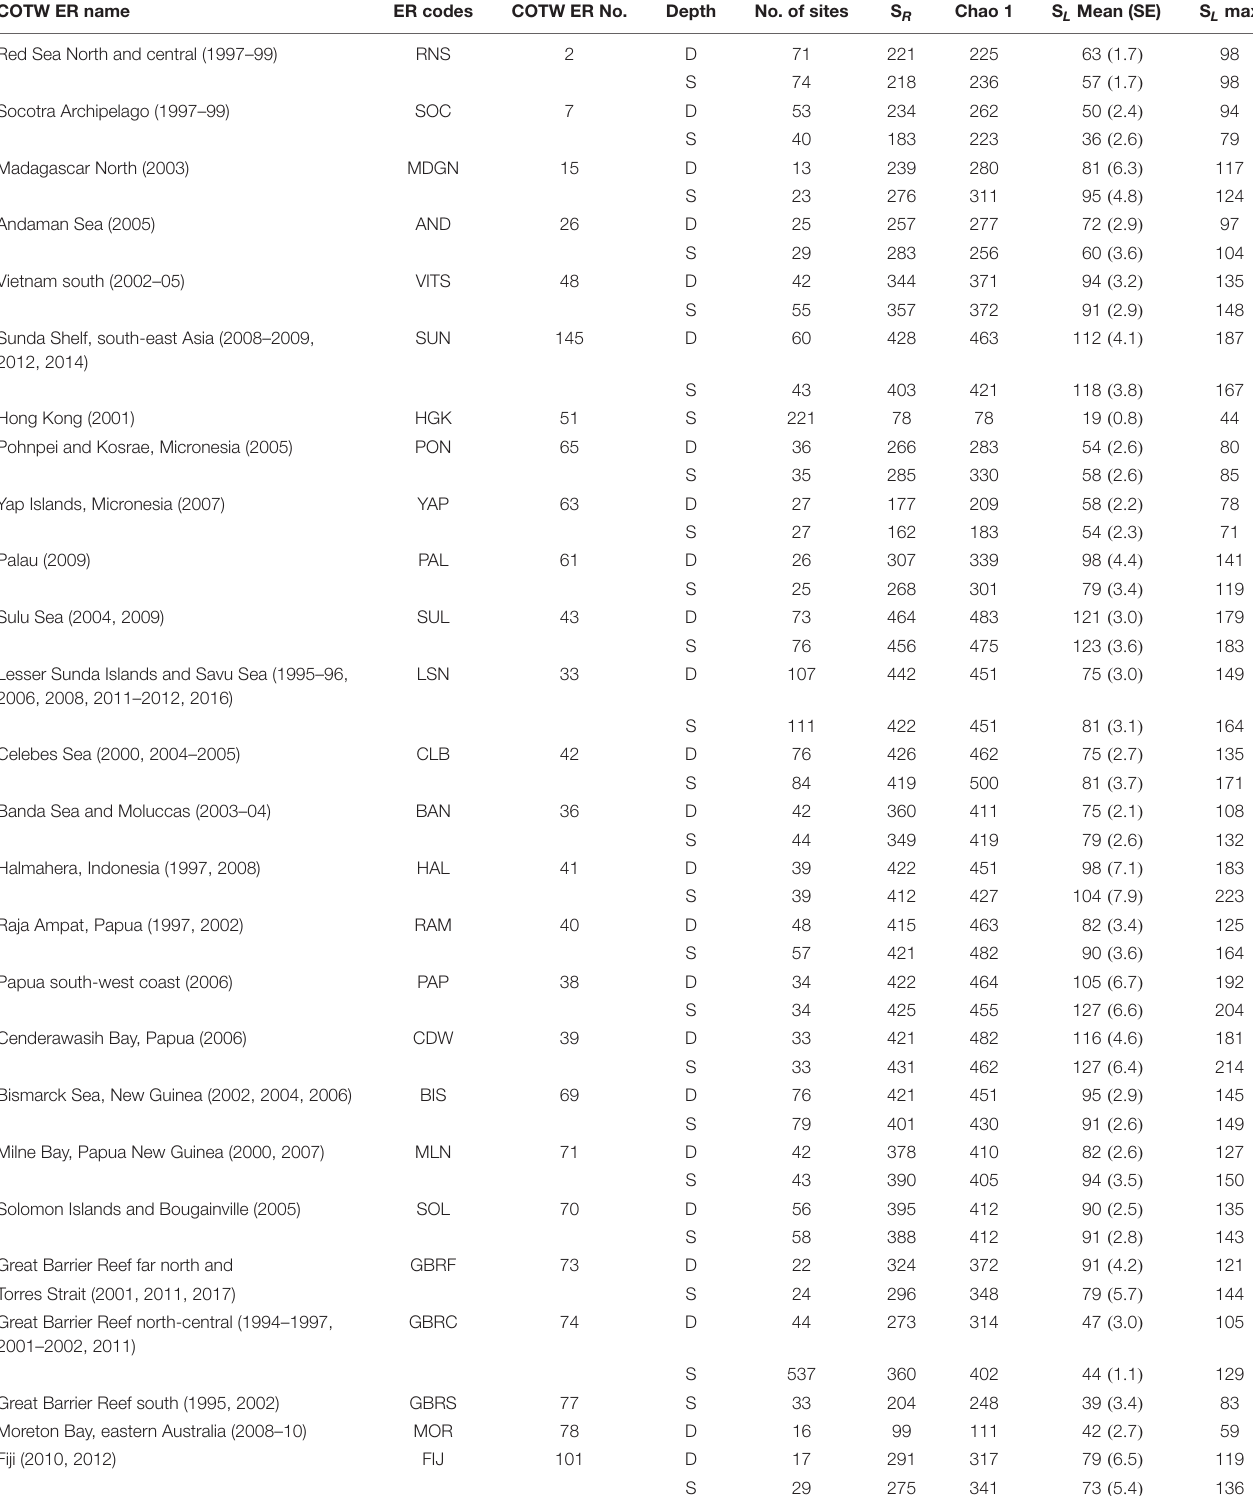
TABLE 1 | Summary of ER coral richness estimates for deep (D) and shallow (S) sites, including regional species richness (S R ), the Chao1 estimate, mean local species richness (S L Mean) with standard error (SE), and maximum local species richness (S L